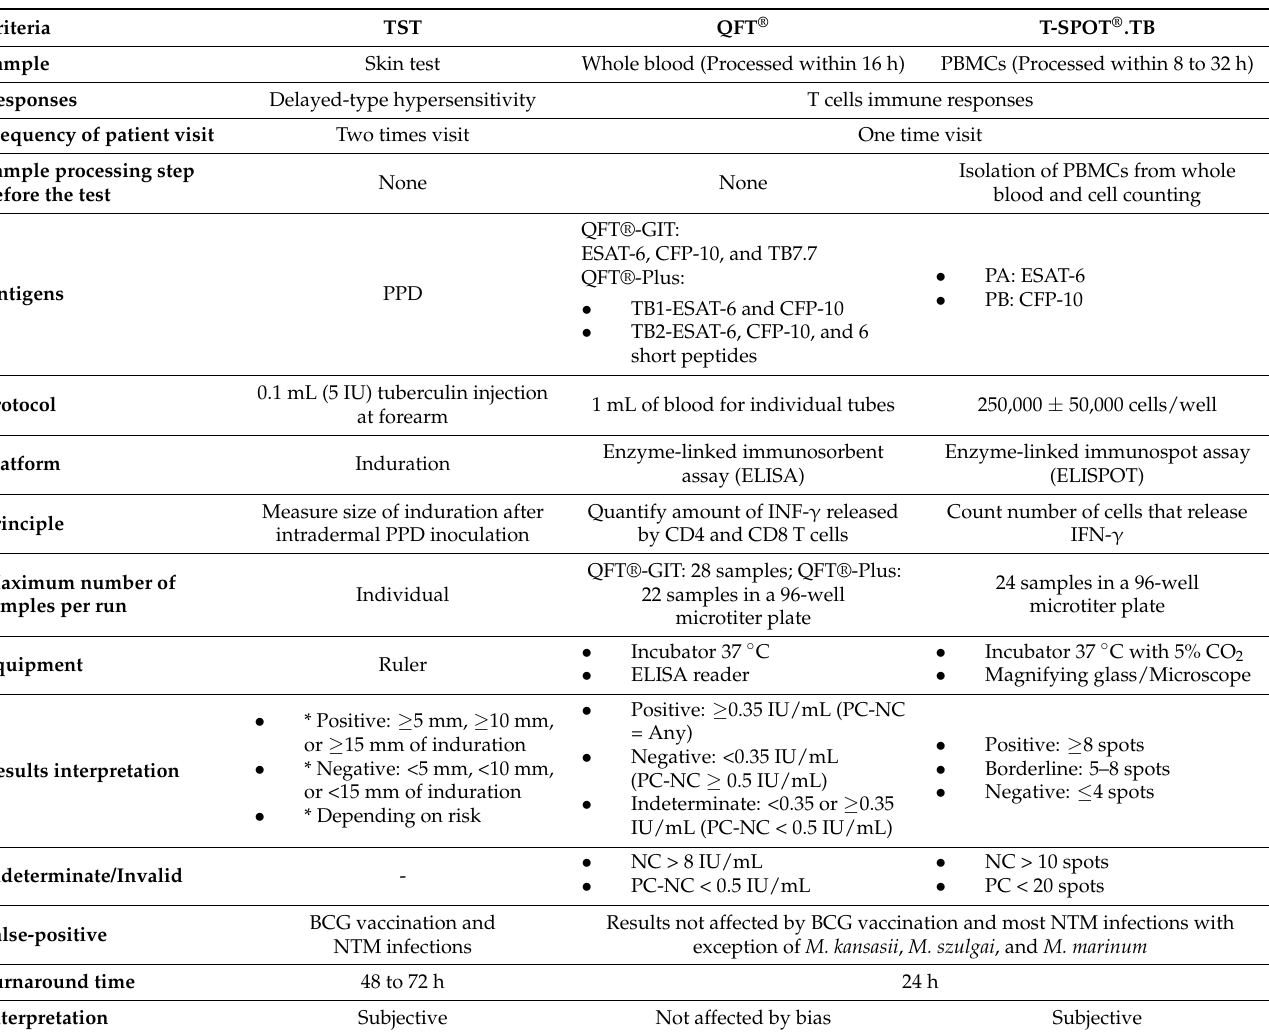
Table 2. Differences between TST, QFT ® , and T-SPOT ®